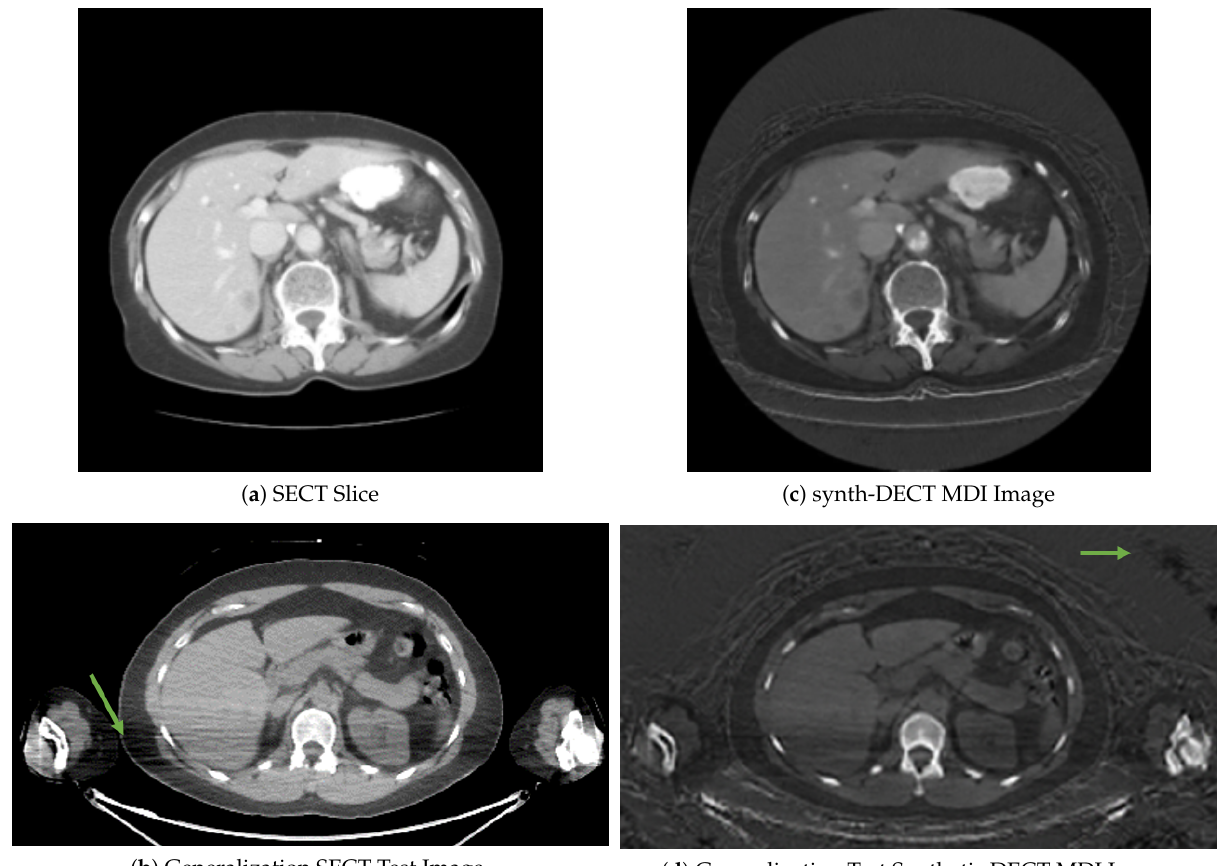
Figure 2. Cross sectional axial slices comparing the image-to-image translation for scans in CT-ORG. ( a ) A single axial slice from a patient single energy CT (SECT) scan. ( b ) Representative slice from one of the nine PET/CT scans used as the generalization test set: The streaks pointed to by the arrow are photon starvation artifacts that result from excess attenuation caused by the arms being at the side during the scan. ( c ) The synthetic dual energy CT material density iodine (synth-DECT MDI) image for the slice shown in ( a ). ( d ) The synth-DECT MDI image of the slice is shown in ( b ). The arrow in the synthetic slice shown in ( d ) points to a region in the air surrounding the patient that was